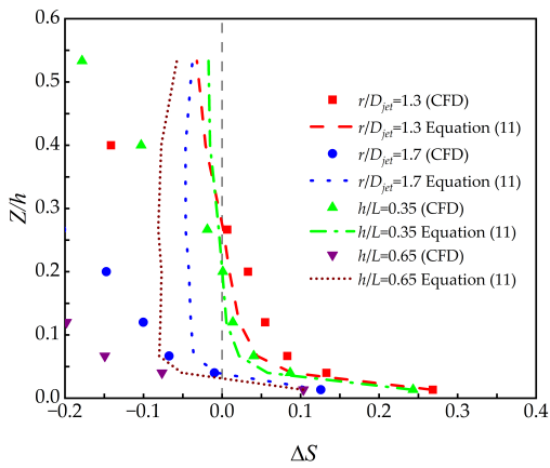
Figure 19. Validation of Speedup ratio for vertical distribution at the hilltop.